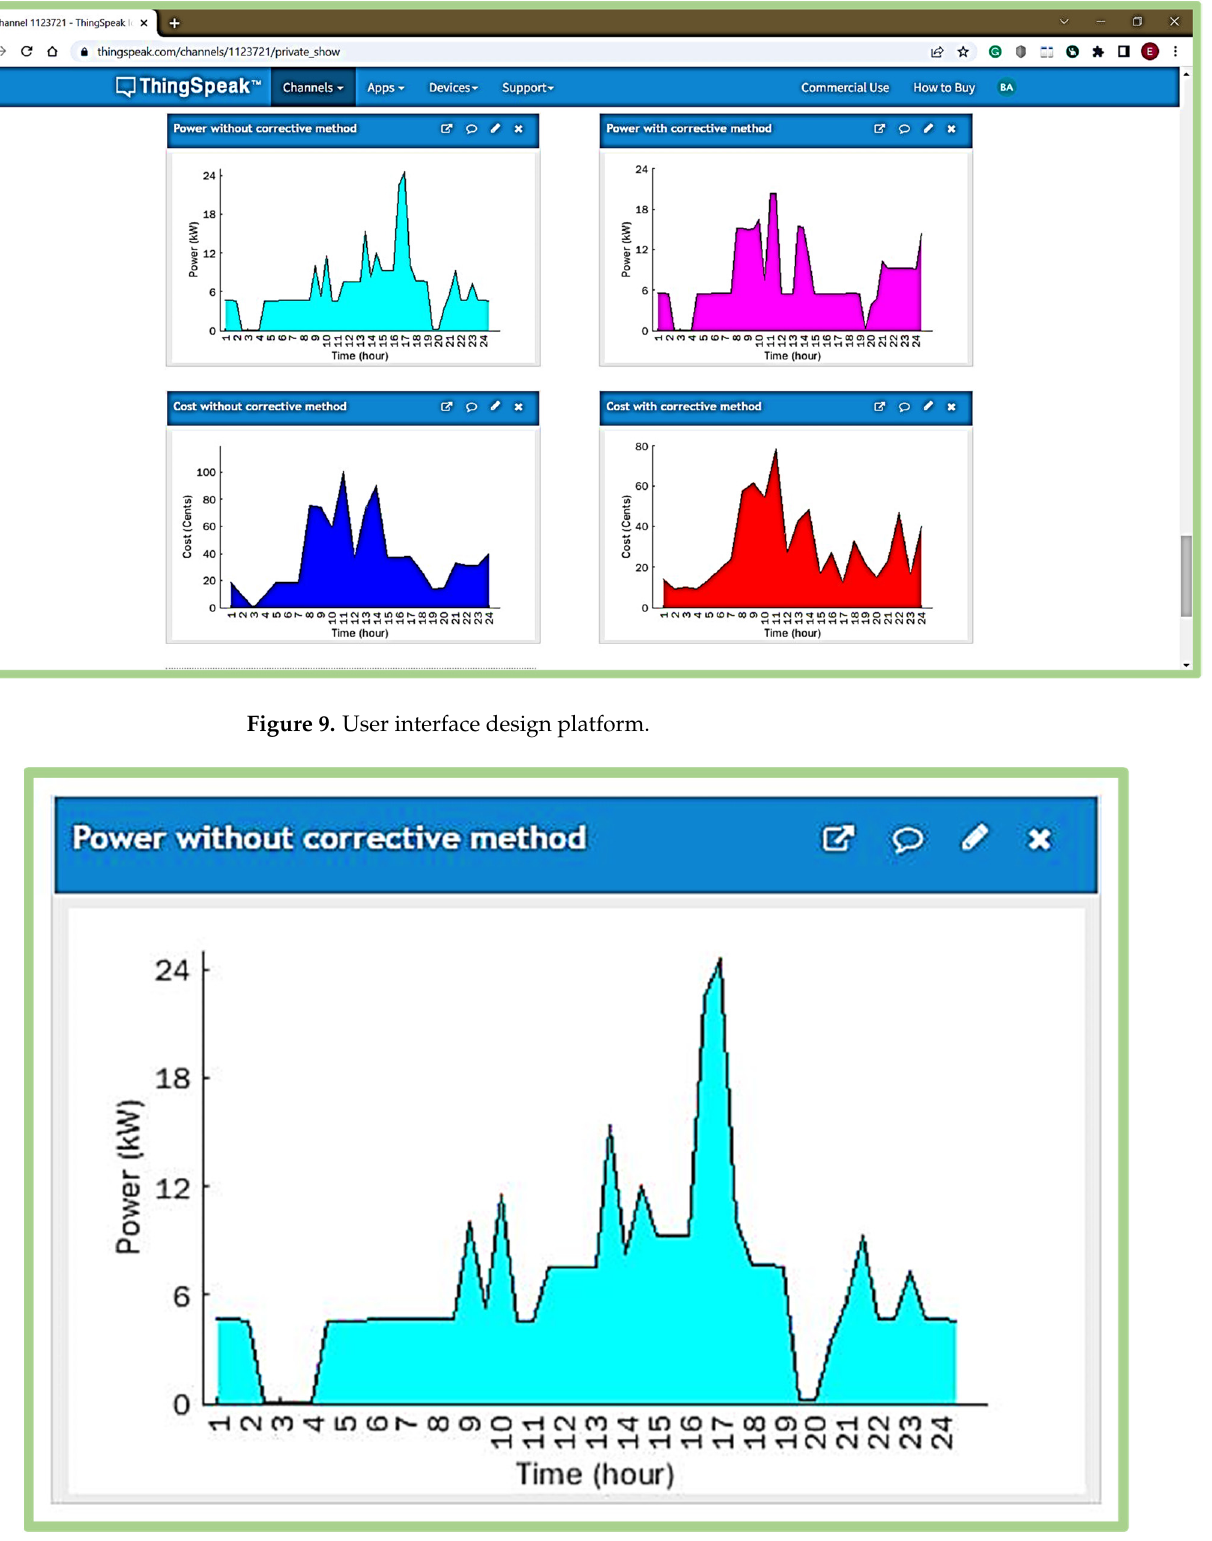
Figure 10. Power GUI of suggested EMS without the corrective method.